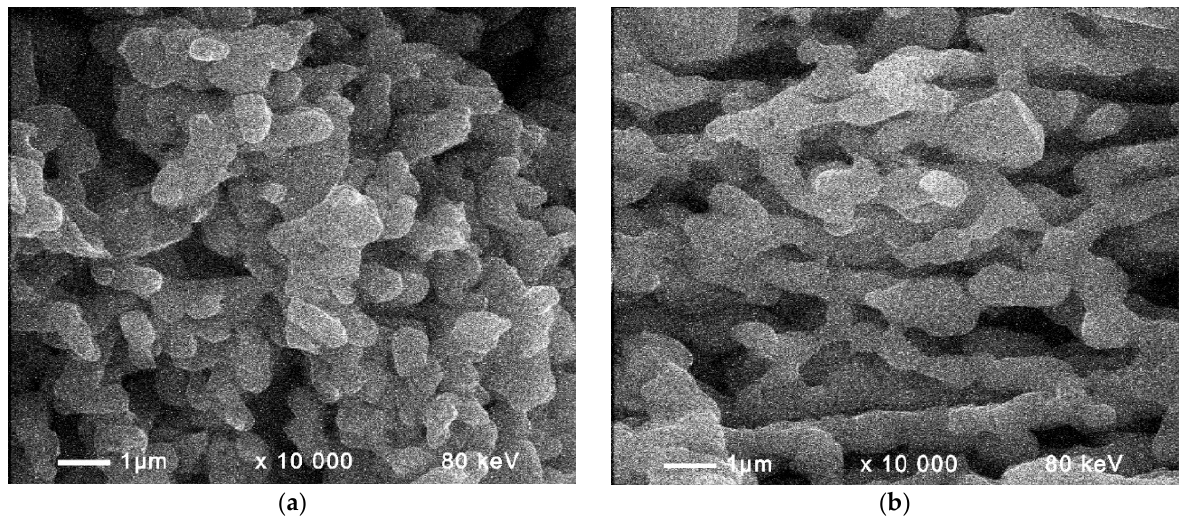
Figure 6. SEM micrographs of the negative active mass of control battery CB1 ( a ) and battery formed with external influence of a multivector field MVFB2 ( b ) after formation.